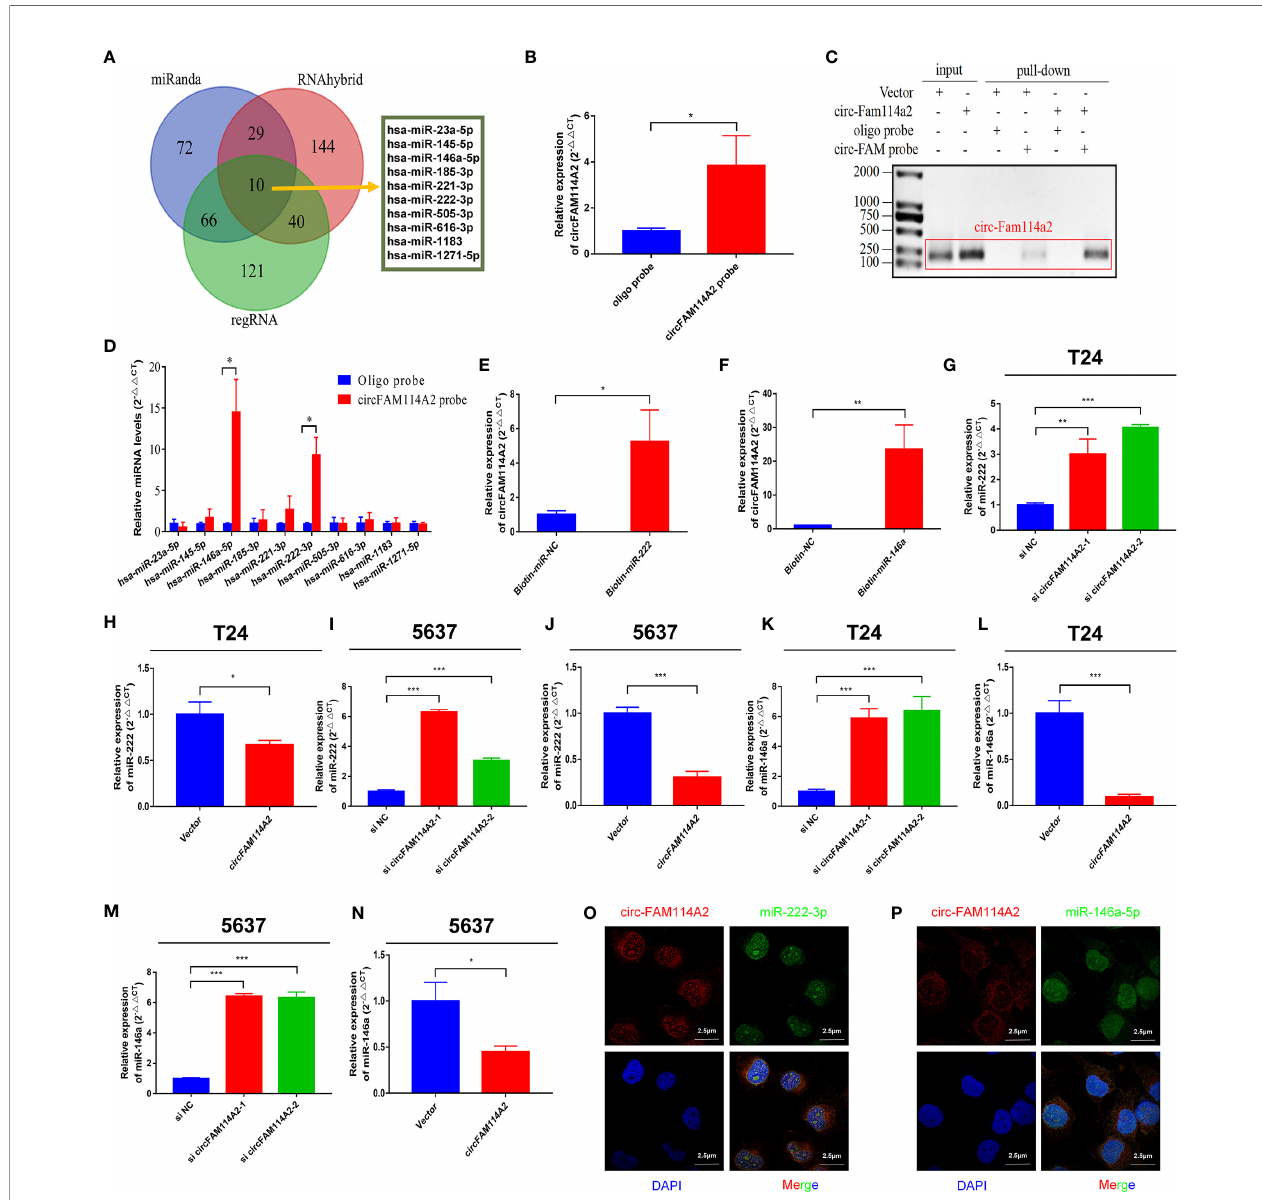
FIGURE 3 | CircFAM114A2 acted as a sponge for miR-222-3p and miR-146a-5p in urothelial carcinoma cells. (A) Schematic illustration showed overlapping of the target miRNAs of circFAM114A2 predicted by miRanda, regRNA, and RNAhybrid. (B) CircFAM114A2 was pulled down from T24 lysates after transfection with the circFAM114A2 biotinylated probe and investigated with quantitative real-time PCR (qRT-PCR) (Student ’ s t -test: * p < 0.05). (C) CircFAM114A2 in urothelial carcinoma cell lysates was pulled down and enriched with a circFAM114A2-speci fi c probe and then detected by qRT-PCR. The ampli fi cation products were con fi rmed by agarose gel electrophoresis. The relative level of circFAM114A2 was normalized to input. (D) The relative levels of 10 miRNA candidates in the urothelial carcinoma cell lysates were detected by qRT-PCR (Student ’ s t -test: * p < 0.05). (E, F) Biotin-coupled miR-222-3p/miR-146a-5p captured a fold change of circFAM114A2 in the complex as compared with biotin-coupled nonsense control (NC) in biotin-coupled miRNA capture (Student ’ s t -test: * p < 0.05, ** p < 0.01). (G, H) The expression level of miR-222-3p was detected by qRT-PCR in circFAM114A2 knockdown and overexpression T24 cells (Student ’ s t -test: * p < 0.05, ** p < 0.01, *** p < 0.001). (I, J) The expression level of miR-222-3p was detected by qRT-PCR in circFAM114A2 knockdown and overexpression 5637 cells (Student ’ s t -test: *** p < 0.001). (K, L) The expression level of miR-146a-5p in circFAM114A2 knockdown and overexpression T24 cells was detected by qRT-PCR (Student ’ s t -test: *** p < 0.001). (M, N) The expression level of miR-146a-5p was detected by qRT-PCR in circFAM114A2 knockdown and overexpression 5637 cells (Student ’ s t -test: * p < 0.05, *** p < 0.001). (N) Expression level of miR-146a-5p in circFAM114A2 overexpression 5637 cells. (O, P) RNA fl uorescence in situ hybridization (FISH) for circFAM114A2 and miR-222-3p/miR-146a-5p was detected in T24. Nuclei was stained blue (DAPI), circFAM114A2 was stained red , and miR-222-3p/miR-146a-5p were stained green . Data are the mean ± SD, n =